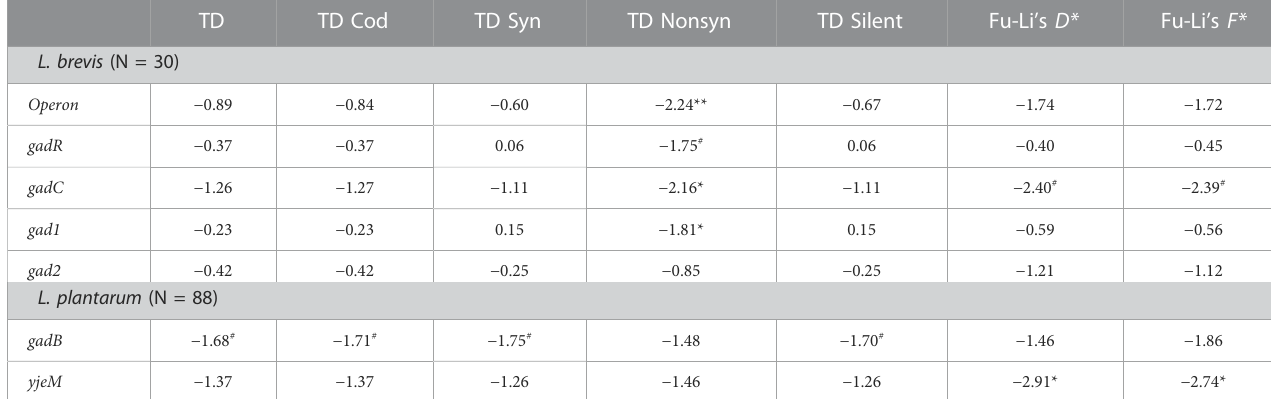
TABLE 2 Neutrality tests summary statistics for glutamate decarboxylase pathway genes in the examined L. brevis and L. plantarum